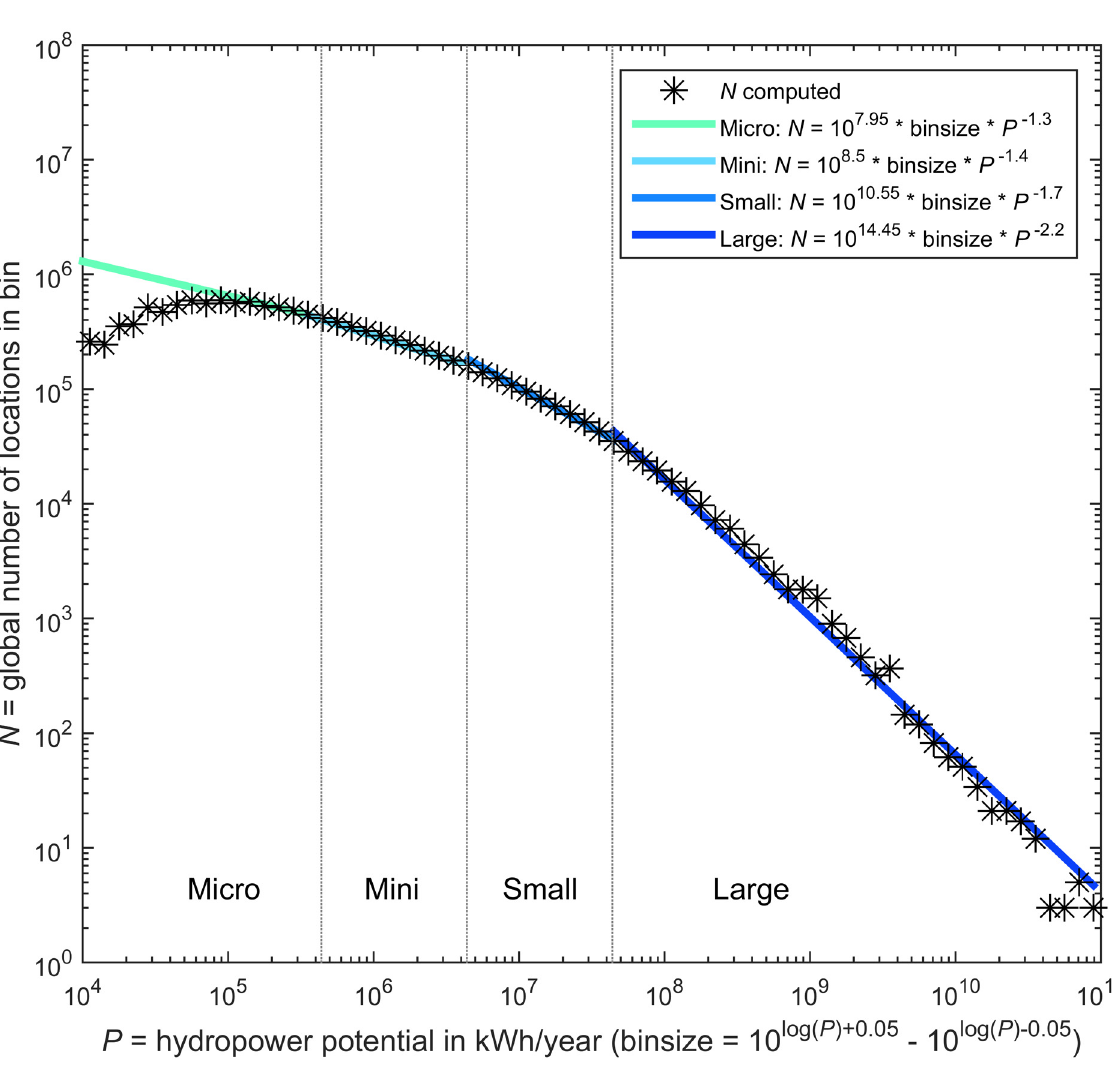
Fig 4. Global map of gross hydropower potential distribution. Large ( > 10MW), small (1–10 MW), mini (0.1–1 MW), micro (0.005–0.1 MW), and pico( < 0.005MW) plants.